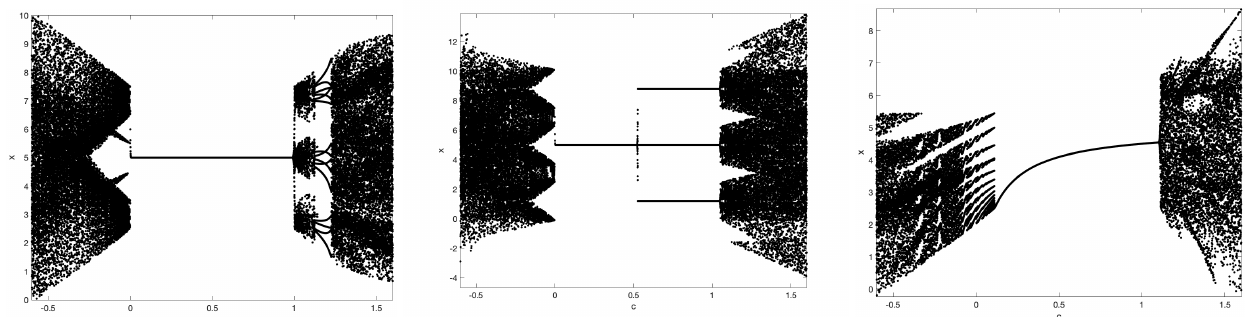
Figure 8. Bifurcation diagrams with respect c of the fundamental map. ( left ) shows the diagram with a = 1, b = 1.9 and c ∈ [ − 0.6,1.6 ] . ( middle ) shows the diagram with a = 1, b = 1 and c ∈ [ − 0.6,1.6 ] . ( right ) shows the diagram with a = 0.9, b = 0.9 and c ∈ [ − 0.6,1.6 ] . Note that having a and b lower than 1 enlarge the area in which a lower/negative c generates chaos.